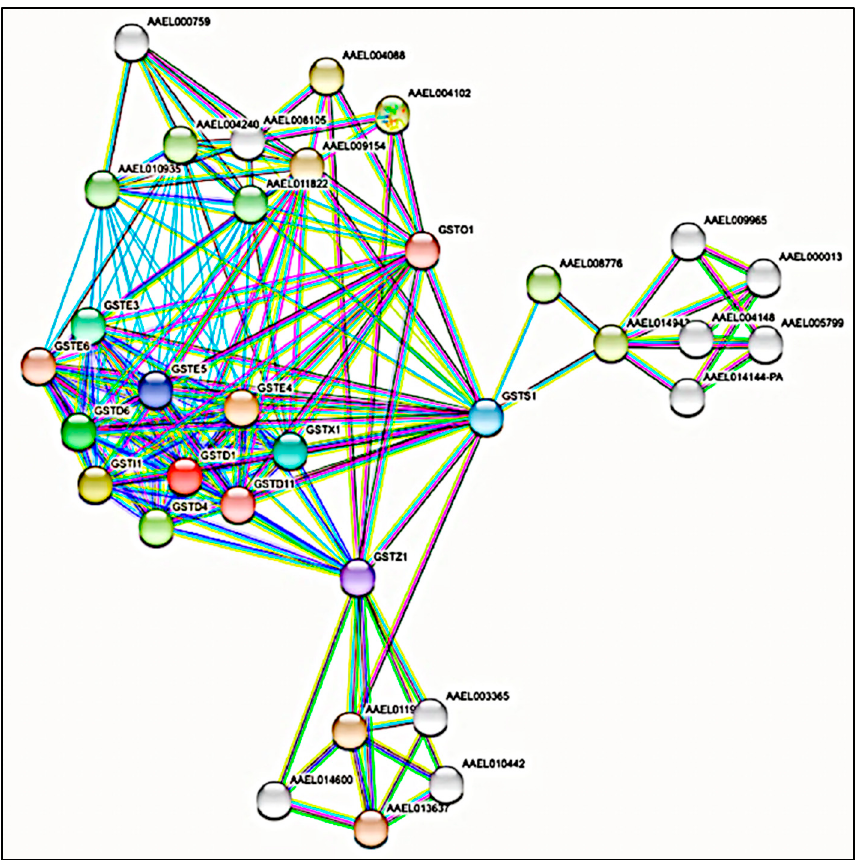
Figure 1. The interactive network view of Aedes GSTs with predicted proteins of protein-protein interactions analysis using STRING 11.5 tool at PPI enrichment p -value < 1.0 × 10 − 16 . Network nodes are proteins, and the edges represent the predicted functional associations. The K-means algorithm was used to cluster the proteins in 13 different GST classes. Every colored node corresponds to a cluster. Inter-cluster edges are represented by dashed lines. Table 3. Characteristics of biological process and molecular function of protein-protein interaction of GSTs with metabolic detoxification related protein STRING 11.5.